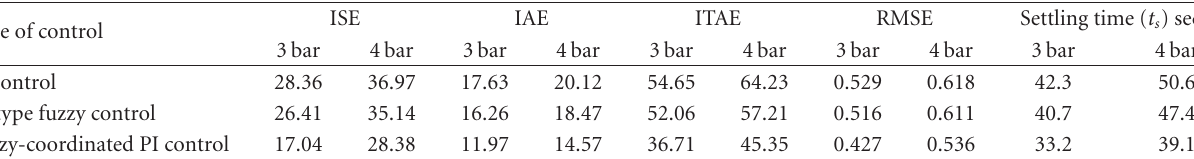
Table 3: Performance comparison of di ff erent control algorithms.